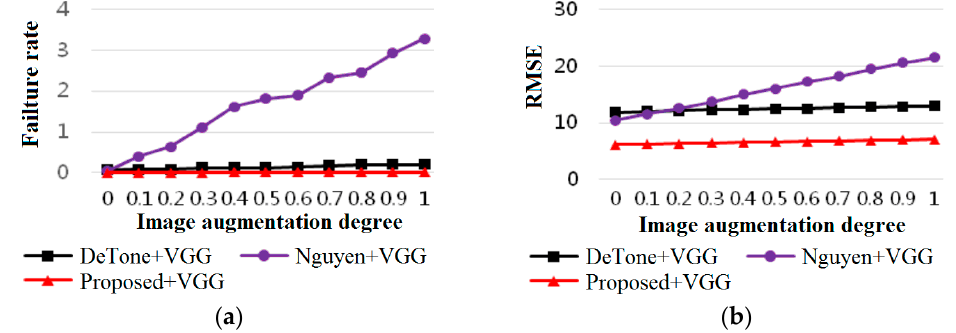
Figure 3. Robustness of DeTone’s algorithm, Nguyen’s algorithm and the proposed algorithm using VGG: ( a ) Failure rate; ( b ) RMSE.